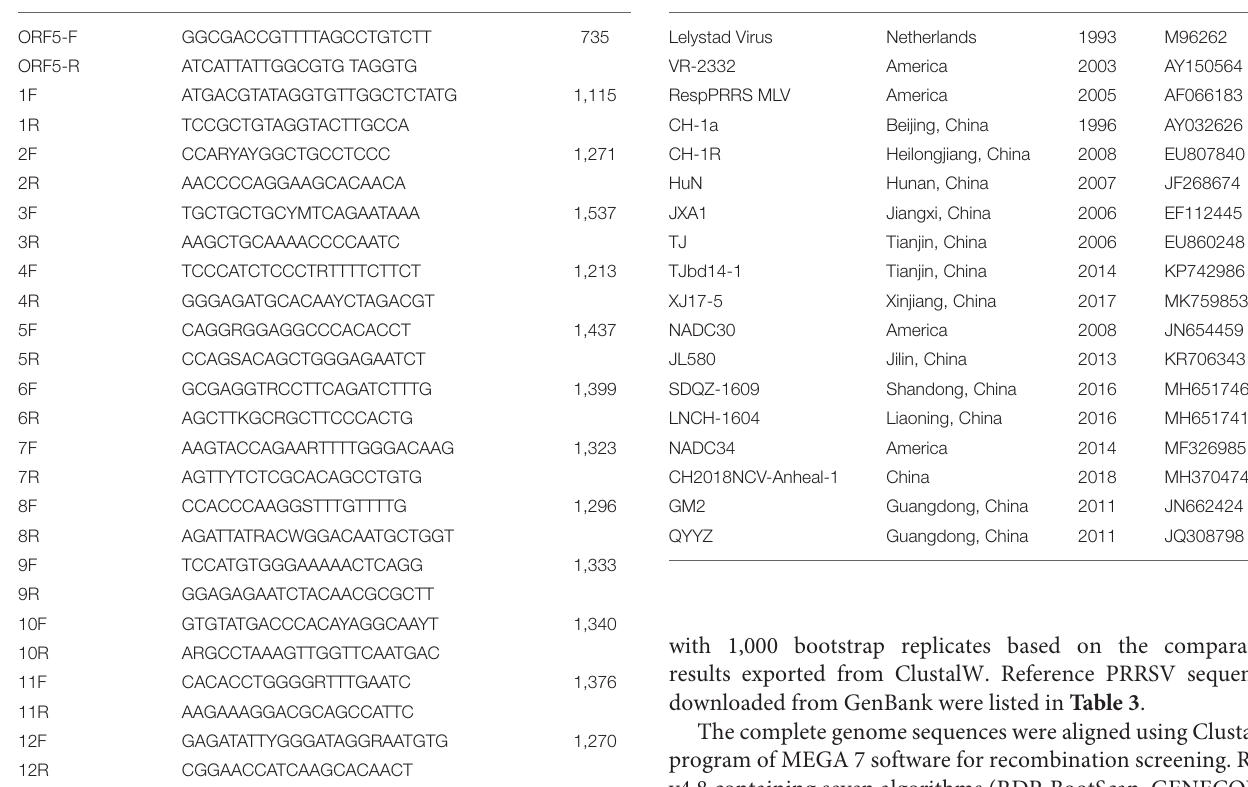
TABLE 3 | Information of the PRRSV reference strains used in this study.